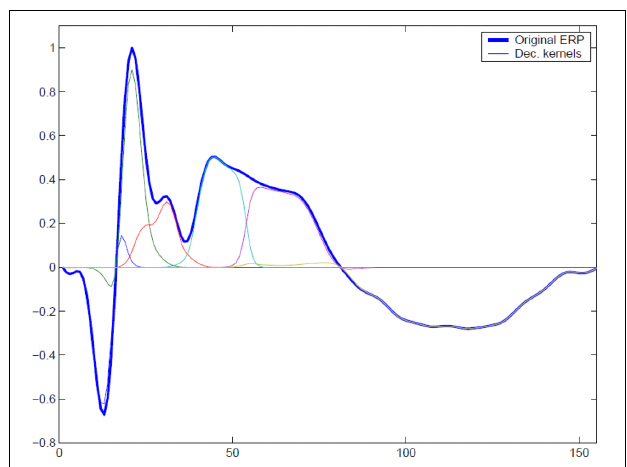
FIGURE 4 | Discriminating power indicator q as a function of source amplitudes ratio for different number of trials calculated for MI and SV spectra. Each curve corresponds to a fixed datapoints count. We can see that the proposed MI based measure outperforms power based technique and produces a clearer cut between the task-related and task-unrelated